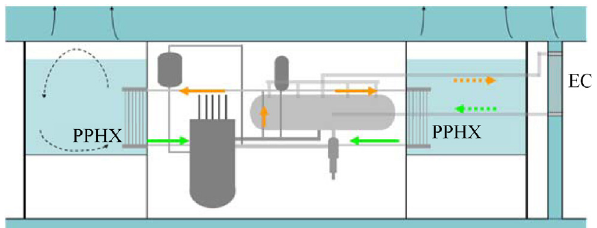
Fig. 3. Targeted safe state when primary circuit is